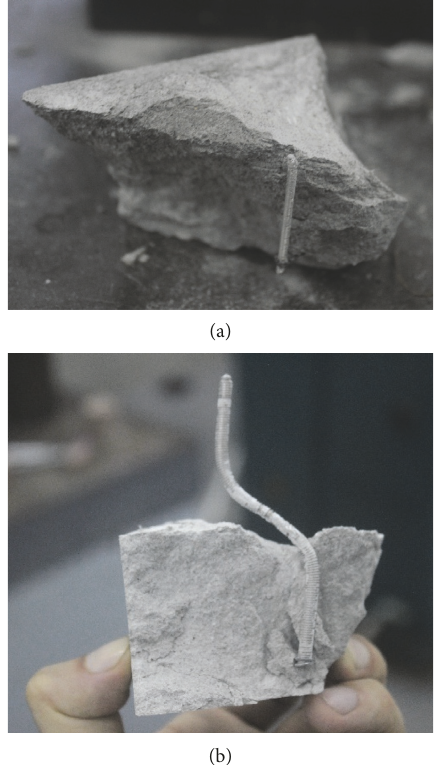
Figure 10: Failure of bolts. (a) Diameter of bolt � 2mm; (b) di- ameter of bolt �